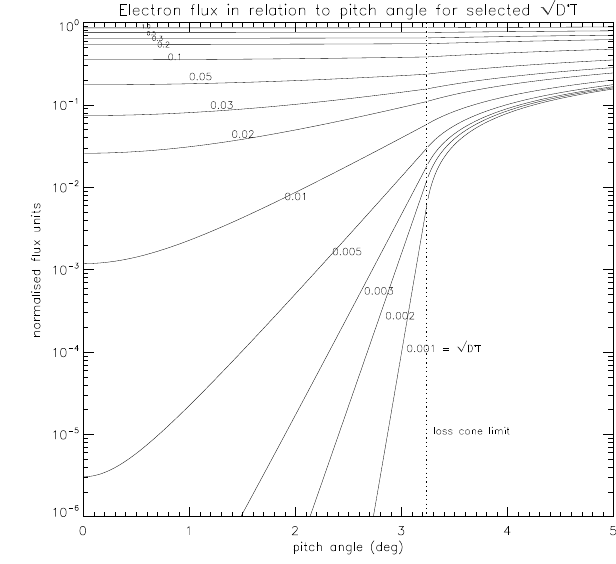
Figure 7: Electron flux in relation to pitch angle for selected values of diffusion parameter (after Kennel & Fig. 7. Electron flux in relation to pitch angle for selected values of Petschek, 1966). diffusion parameter (after Kennel and Petschek, 1966).